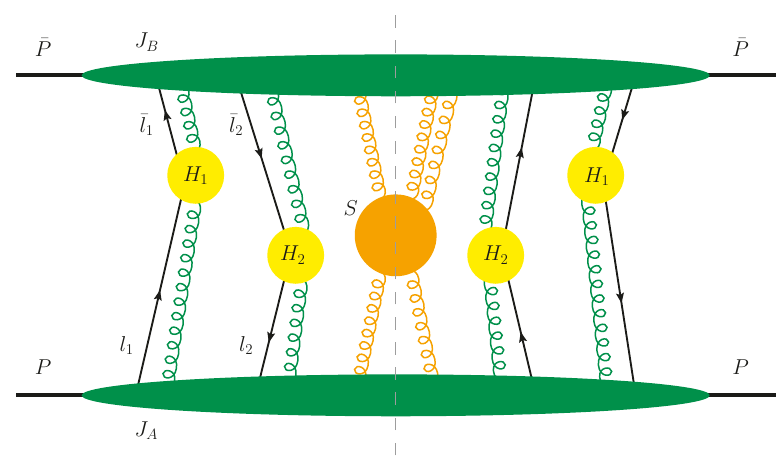
Figure 1 . Structure of the leading graphs in TMD factorisation for the double Drell-Yan process. H 1 and H 2 denote the combination of hard subgraphs to the left and to the right of the (cid:12)nal-state cut, which is represented by the vertical dashed line. For the sake of clarity, the electroweak gauge bosons emerging from H 1 and H 2 are not shown here and in the next